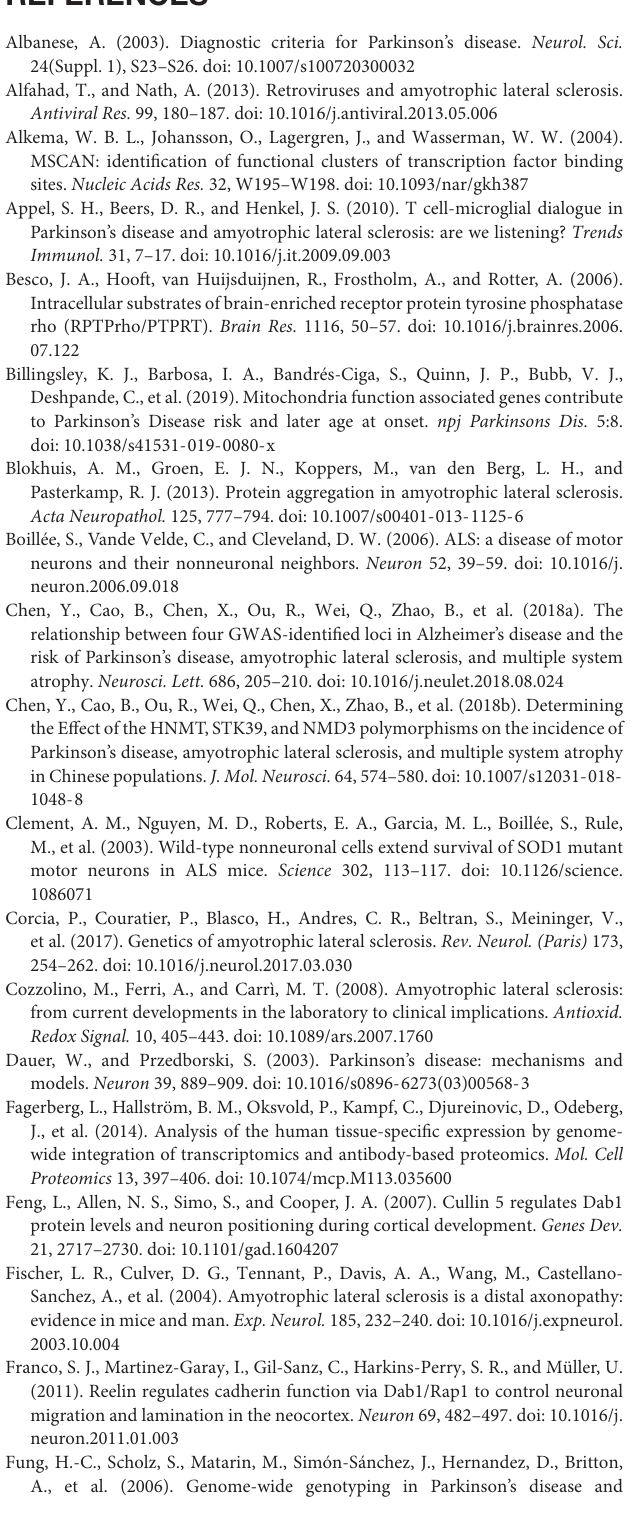
involved in 36 biological processes and PTPRT was involved in six. Related biological processes are shown in black square boxes in red